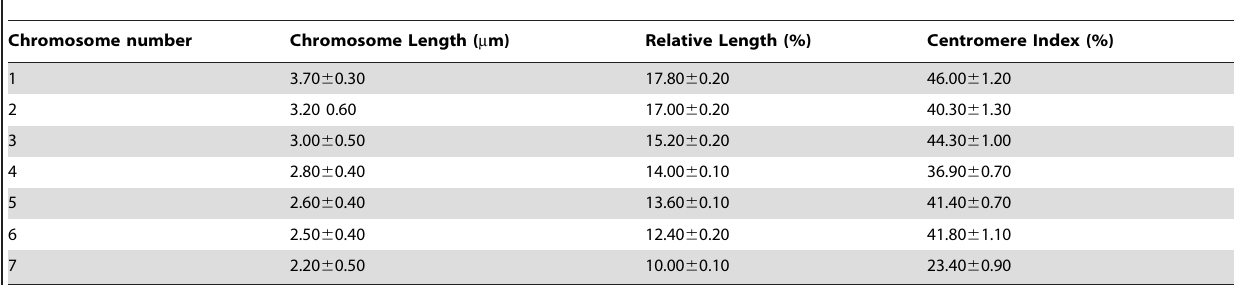
Table 3. Size and centromere index of the Rosa wichurana chromosomes.